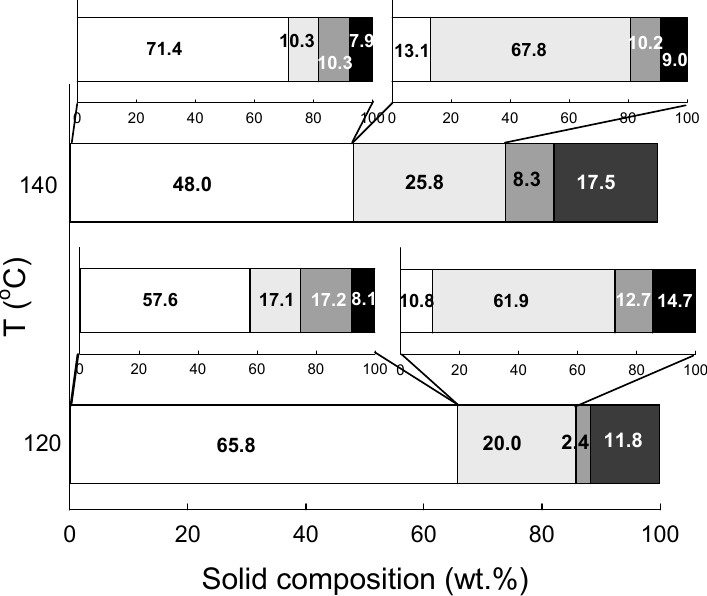
Figure 6. The cellulose- (white bar), hemicellulose- (light grey bar), and Klason lignin-rich (dark grey bar) fractions obtained from wheat straw pre-treated with [emim][OAc] at 120 ◦ C and 140 ◦ C and 2 h. Inserts present the composition of cellulose- and hemicellulose-rich fractions (the same colours were used to differentiate each individual component). Numbers presented in the figure indicate the composition (expressed in wt.%). For exact values, refer to Table S1 in the Electronic Supplementary Information (ESI). Black bars correspond to other non-identified components and were calculated as the difference between biomass used for process or characterised fraction and the cellulose, hemicellulose and lignin determined.